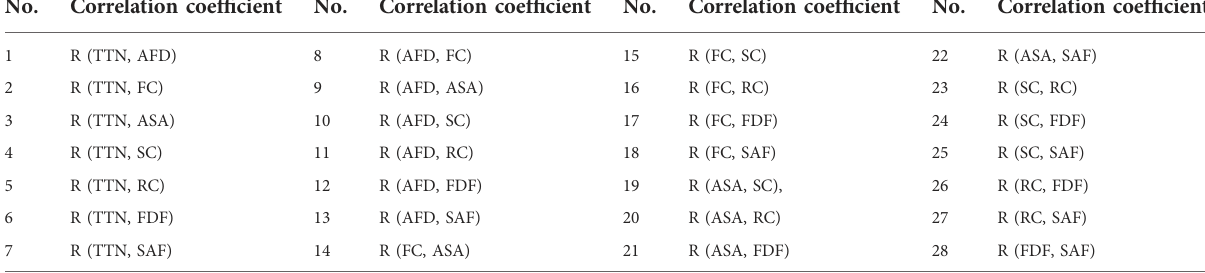
TABLE 2 Sequence number of 28 correlation coef fi cients between two measures.